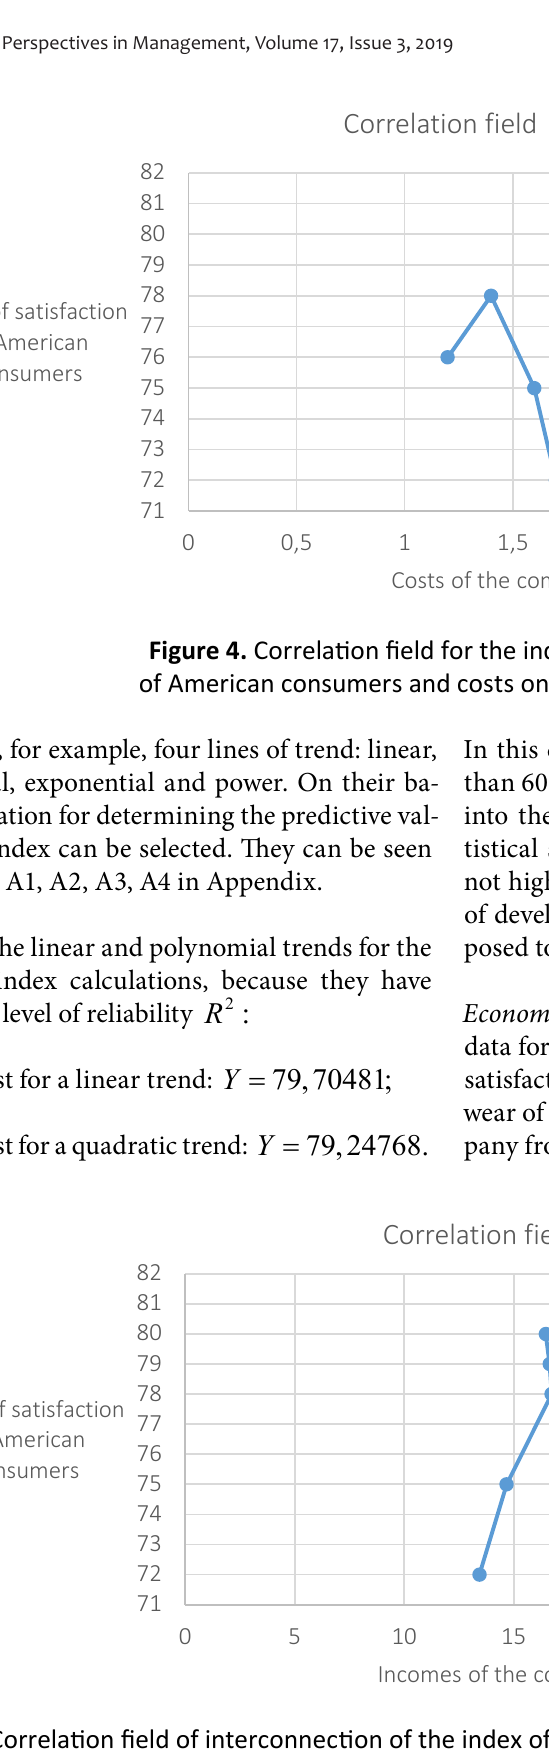
Figure 5. Correlation field of interconnection of the index of satisfaction of American consumers with the company Nike and its incomes, in the period